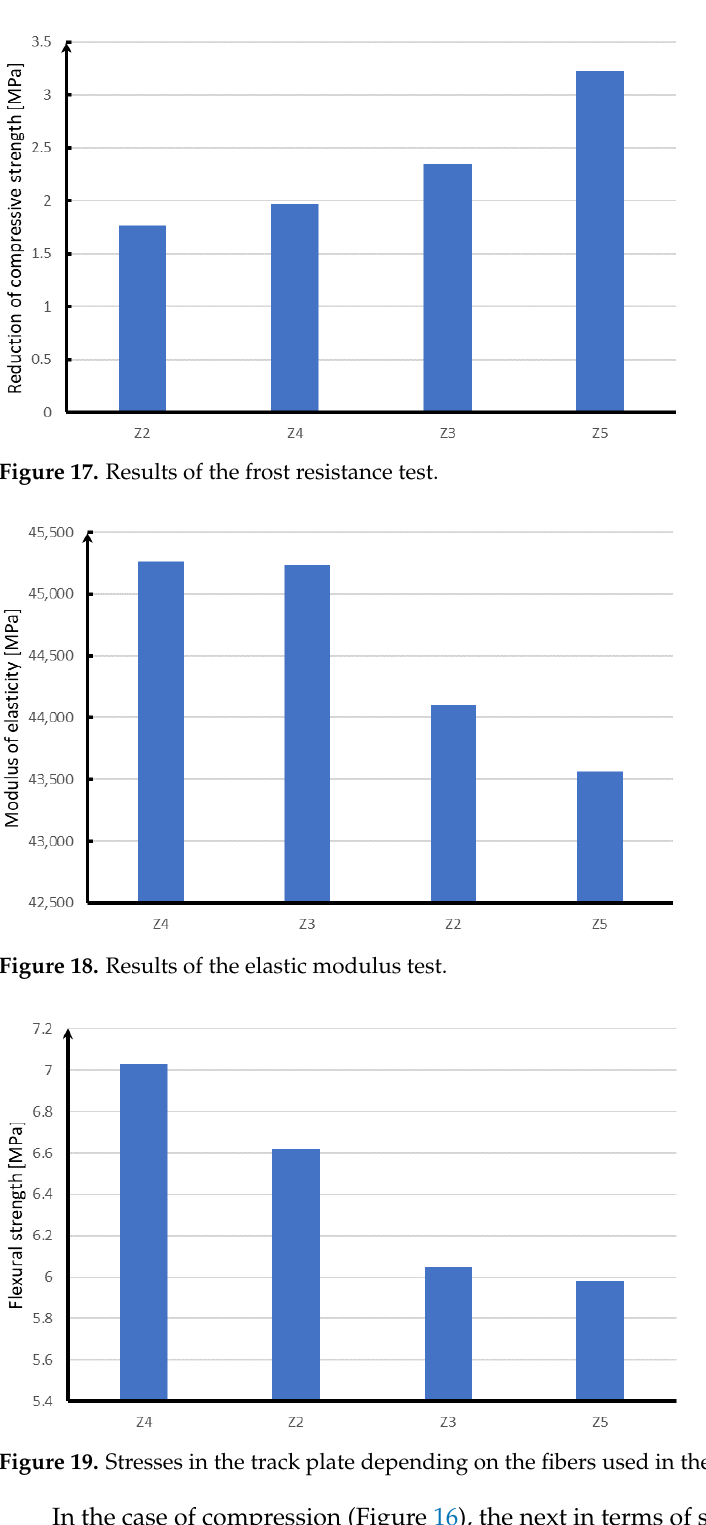
Figure 16 . Results of the compressive strength test.